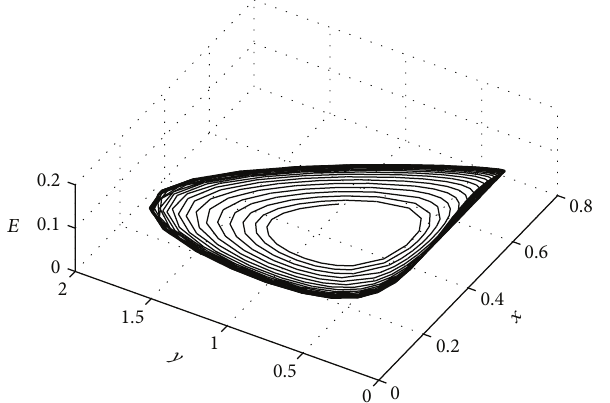
Figure 2: When 𝜏 2 = 0.288 > 𝜏 20 , bifurcating periodic solutions from the equilibrium point 𝑃 0 occur.